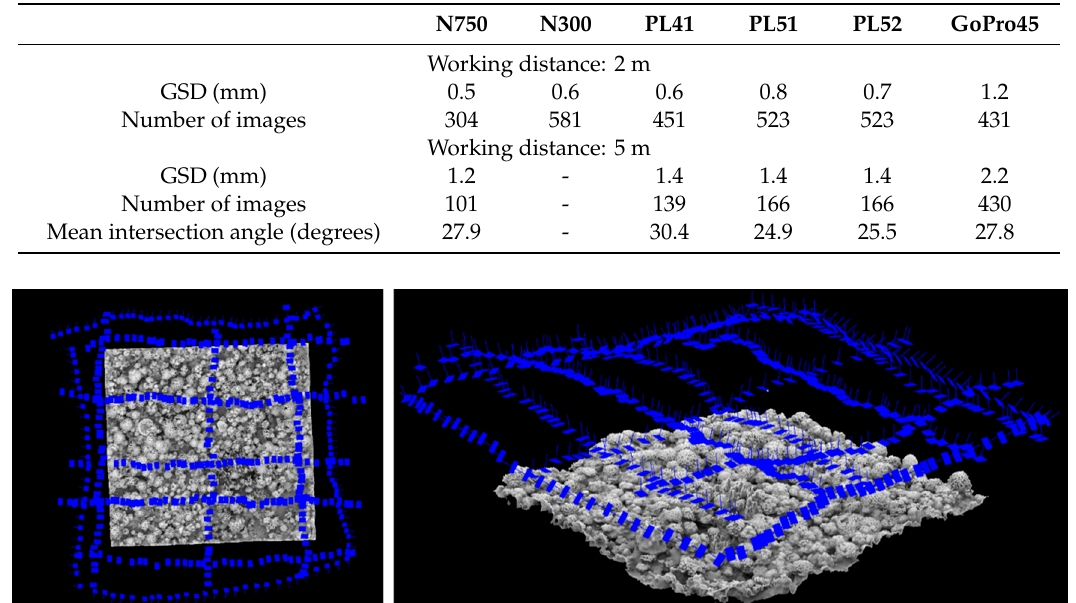
Table 3. Characteristics of underwater photogrammetric systems tested.